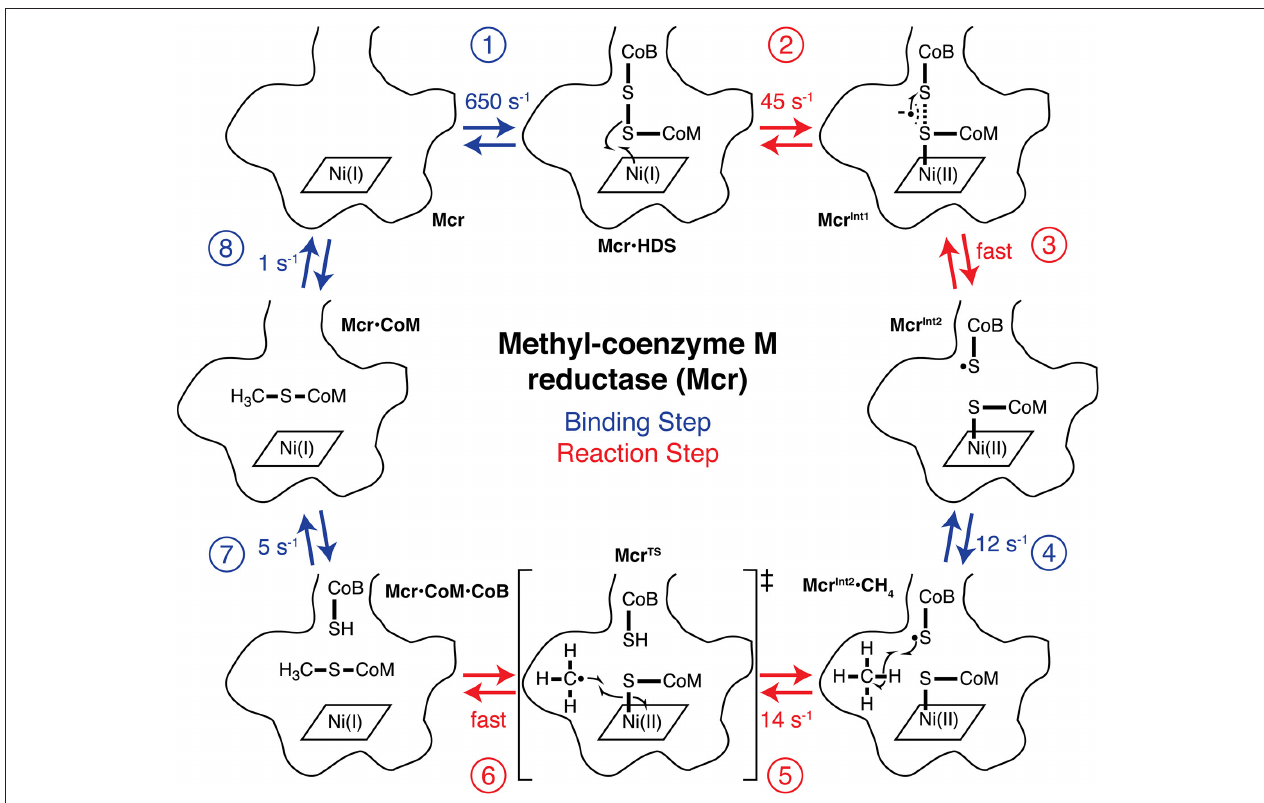
FIGURE 4 | The complete catalytic cycle and associated specific rate constants for AOM by Mcr. The bottom of Mcr’s narrow substrate channel and cofactor F 430 binding are outlined for each step of the mechanism. Each of the reaction intermediates are numbered and labeled. The free state of Mcr first (step 1) binds HDS to form the Mcr · HDS intermediate. Ni(I) (step 2) donates an electron to HDS to form Mcr Int1 , which rapidly (step 3) interconverts to form Mcr Int2 . Mcr Int2 (step 4) binds methane to yield Mcr Int2 · CH 4 , which has a C-H bond homolytically (step 5) cleaved to propagate the radical reaction. The methyl radical is formed as part of the reaction’s transition state (Mcr TS ). The Ni(II)-thiolate is homolytically (step 6) cleaved and donates an electron to the methyl radical, which terminates the radical mechanism. The product of step 6 is the product ternary complex (Mcr · CoM · CoB), where Mcr is bound to both CH 3 -S-CoM and HS-CoB simultaneously. HS-CoB